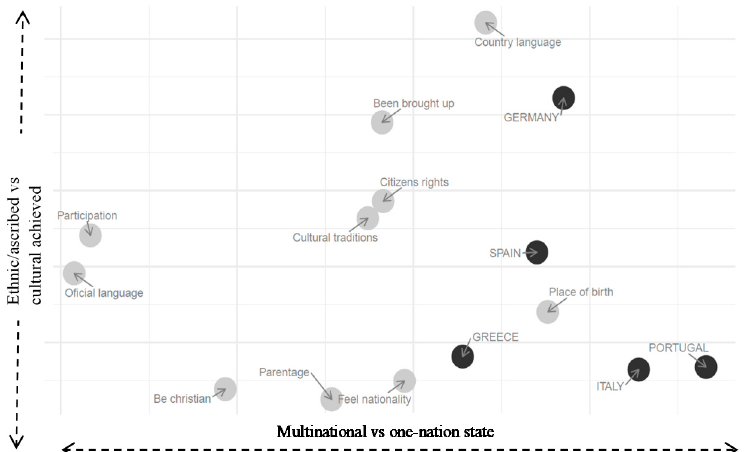
Figure 3. The meaning of national identity in Germany, Spain, Italy, Greece, and Portugal in 2010. Authors’ own elaboration from Eurobarometer 73.3 via unfolding analysis.